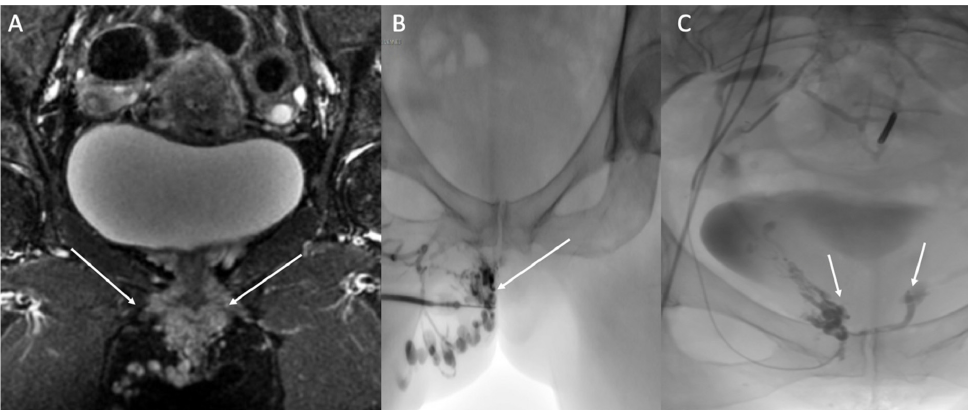
Figure 5. Painful right vulvar and perineal varices of pelvic origin with a pudendal leak point. ( A ) Coronal STIR MRI shows dilated pudendal veins (arrows). ( B ) Sclerotherapy of vulvar varicosities was performed through direct puncture. (0.5% polidocanol foam; arrow). ( C ) Occlusion of the right and left pudendal leak points